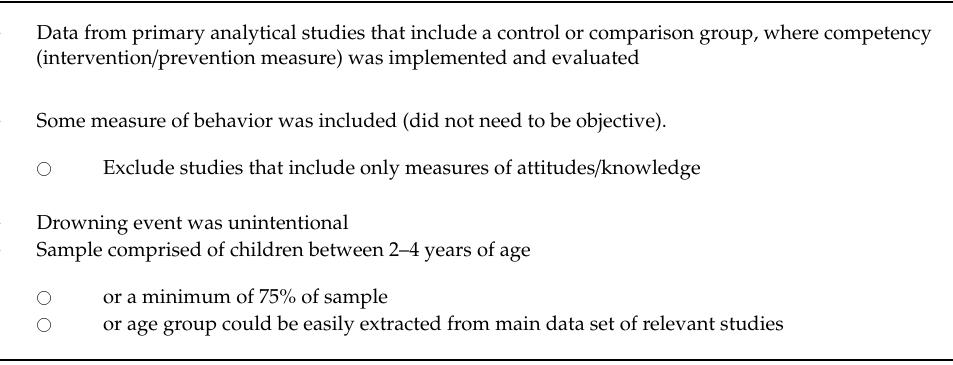
Figure 1. PRISMA Flow Chart outlining procedure of extracting articles for inclusion. Table 1. Inclusion and exclusion